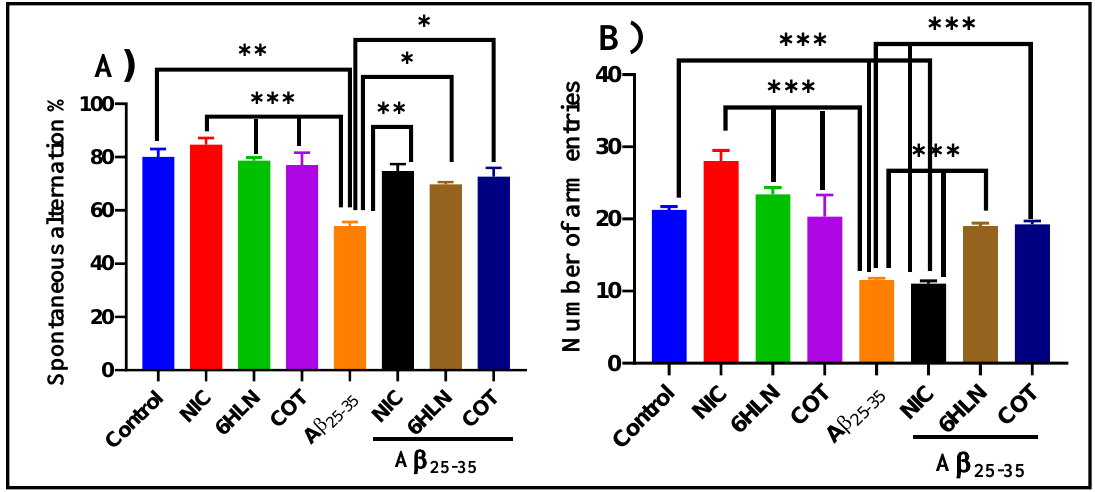
Figure 4. E ff ects of NIC, 6HLN and COT (0.3 mg / kg, b.w., i.p.) administration in A β 25-35 -treated rats on ( A ) spontaneous alternation percentage and ( B ) the number of arm entries in the Y-maze task. Values are expressed as means ± S.E.M. ( n = 6 animals per group). ANOVA analysis identified overall significant di ff erences between groups in ( A ) F(4,10) = 16.5, p < 0.0002 and ( B ) F(4,15) = 130.8, p < 0.0001. For Tukey’s post hoc analyses–( A ) ** Control vs. A β 25-35 , *** NIC vs. A β 25-35, 6HLN vs. A β 25-35 , COT vs. A β 25-35 : p < 0.0001, ** A β 25-35 vs. NIC + A β 25-35 : p < 0.001, * A β 25-35 vs. 6HLN + A β 25-35 , A β 25-35 vs. COT + A β 25-35 : p < 0.01; ( B )*** Control vs. A β 25-35 , Control vs. NIC + A β 25-35 , NIC vs. A β 25-35 , 6HLN vs. A β 25-35 , COT vs. A β 25-35 , A β 25-35 vs. 6HLN + A β 25-35 , NIC + A β 25-35 vs. 6HLN + A β 25-35 , A β 25-35 vs. COT + A β 25-35 , NIC + A β 25-35 vs. COT + A β 25-35 : p < 0.0001.